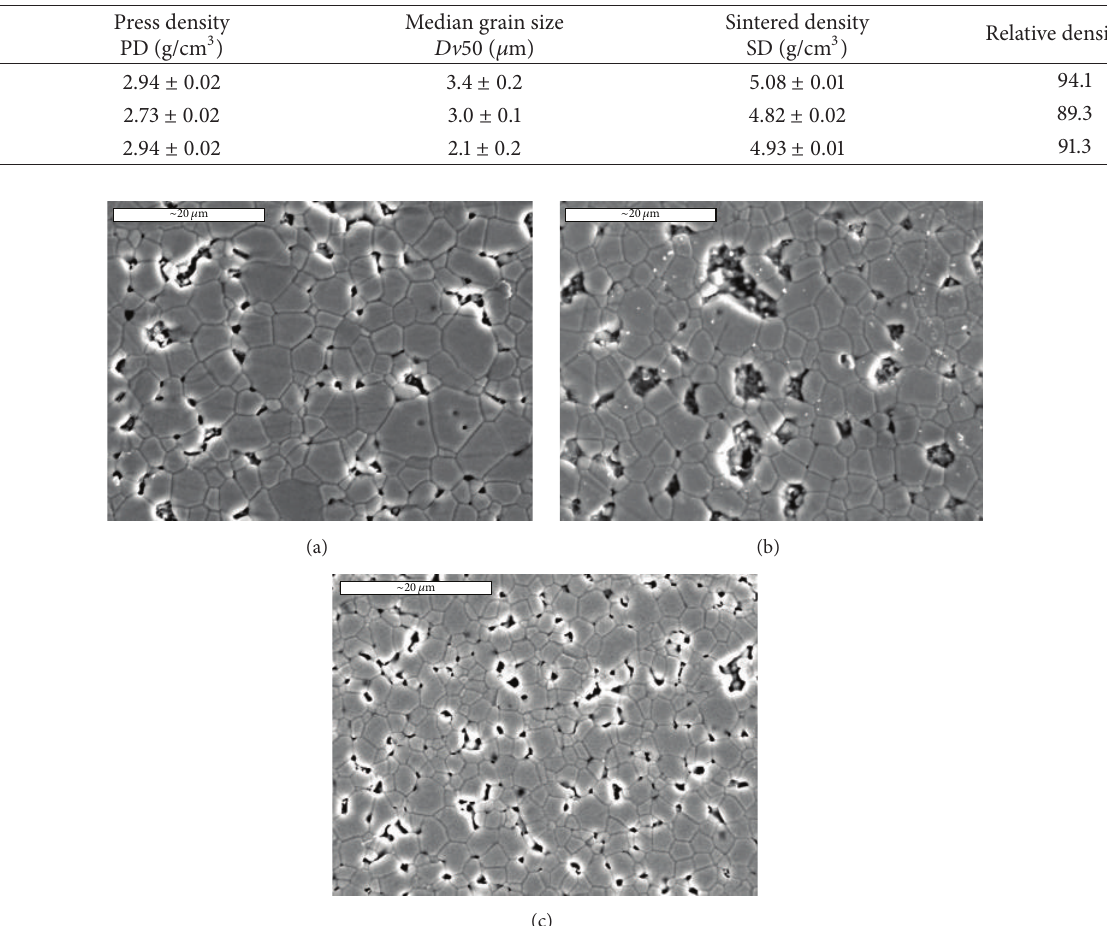
Table 2: Morphology-related properties of the sintered ferrite.